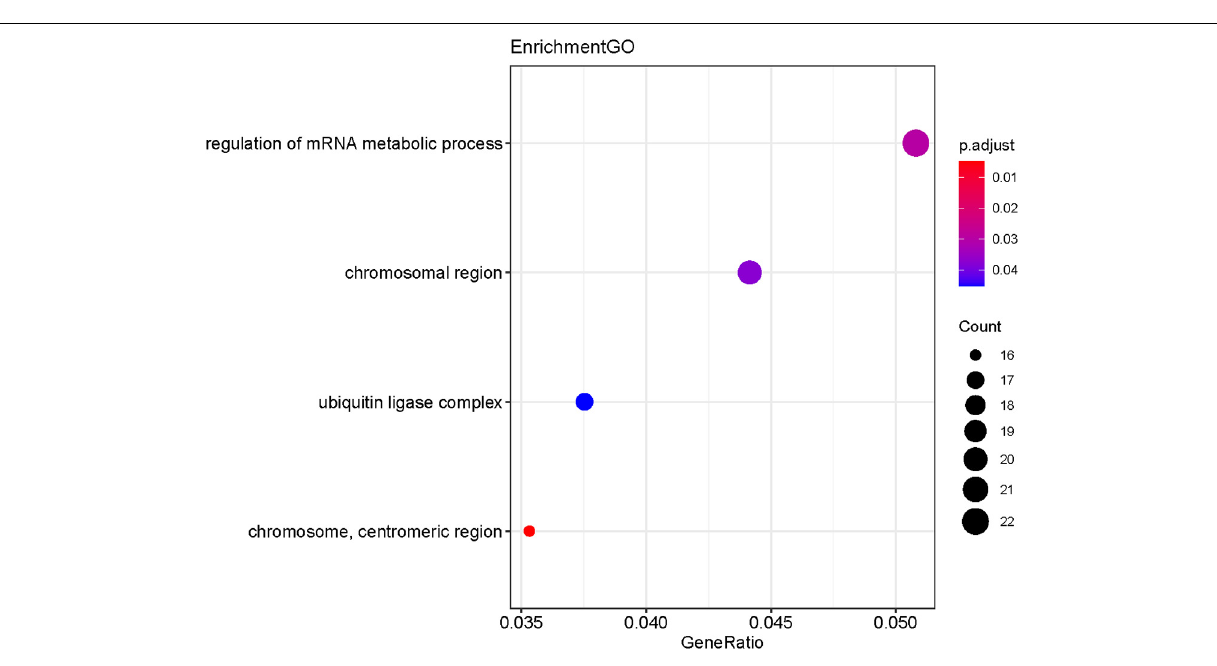
FIGURE 6 | GO functional annotation of the collection of the potential target genes of the DE-miRNAs (miR-492, miR-590-3p, and miR-631). The functions of the target genes were mainly enriched in the regulation of mRNA metabolic process, chromosomal region, ubiquitin ligase complex and chromosome, and centrometric region. P -value < 0.05 was considered statistically